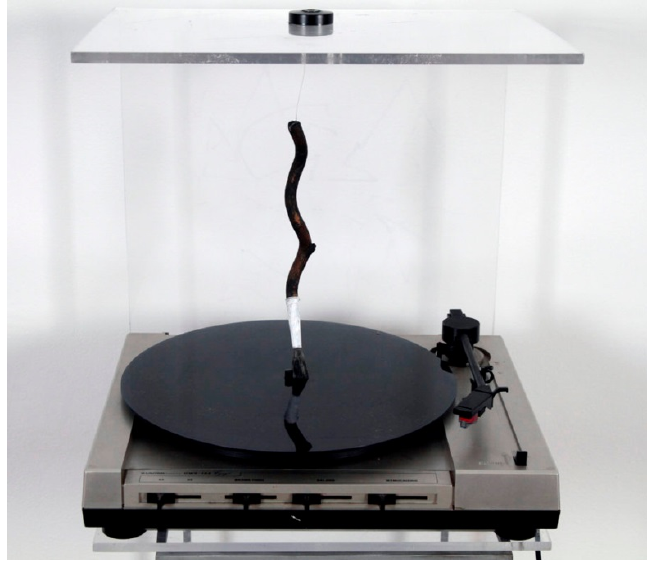
Figure 11. Leon Podsiadły, Obiekt kinetyczny [ Kinetic Object ], 2019, ready made (gramophone, twig-wooden stick). Photography by Andrzej Rerak. Photograph shared courtesy of Entropia Gallery and with the permission of the artist’s family.